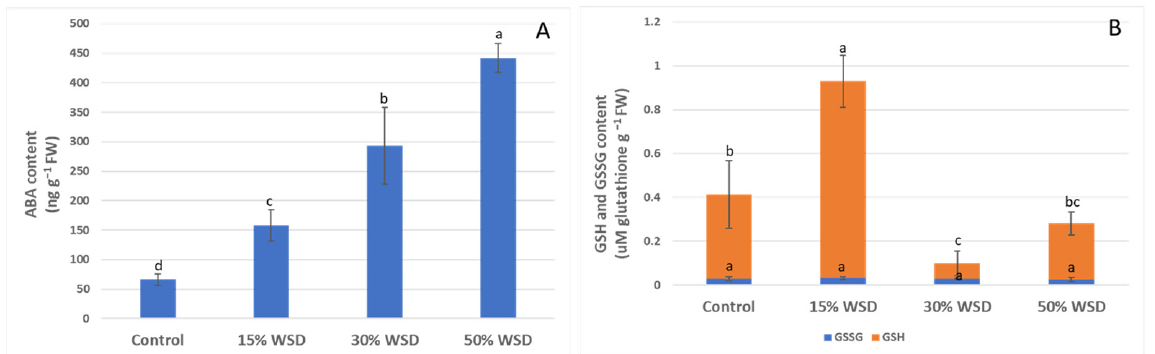
Figure 3. Effect of drought on abscisic acid (ABA) ( A ) and reduced (GSH) and oxidized (GSSG) glutathione ( B ) contents in the control and dehydrated to 15%, 30%, and 50% WSD plants. Vertical bars indicate means ( n = 9) ± standard deviation. Letters indicate Fisher’s least significant differences, which were estimated at a significance level of α =